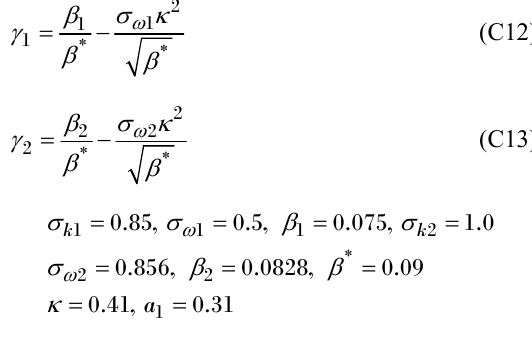
Figure B1.Comparison of the original and transformed wall functions.The solid line with diamonds corresponds to that incompressible boundary layer in new units, Equation B1. The solid line with circles is Musker's function. The dashed lines indicate percent error from Musker's law of the